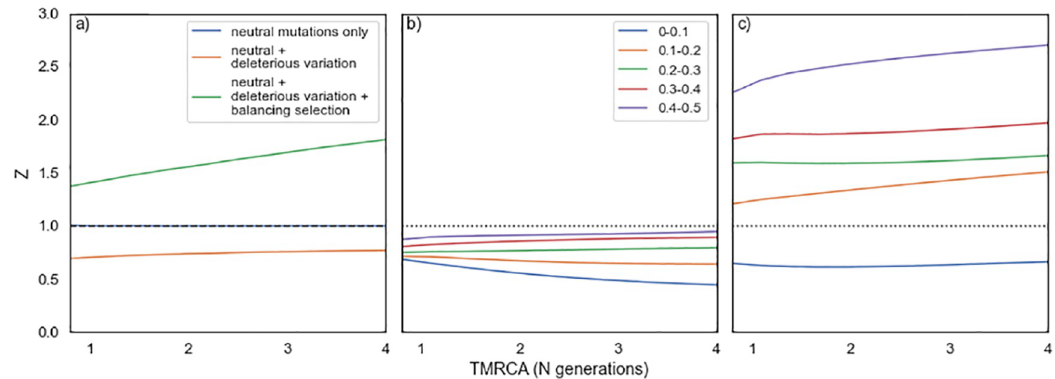
Fig 1. Stationary population size simulations. The ancestral population is duplicated to form 2 daughter populations of the same size to each other and the ancestor. The tMRCA is measured in N generations, where N is the population size. In panel (a), we show the value of Z as a function of the tMRCA for 3 scenarios: all nonsynonymous mutations are neutral; all nonsynonymous mutations are deleterious; and all nonsynonymous mutations are neutral except for a single balanced polymorphism in the middle of the locus. In panels (b) and (c) polymorphisms have been binned by minor allele frequency, in bins of size 0.1. In panel (b), we show the case where all nonsynonymous mutations are deleterious and panel (c) all nonsynonymous mutations are deleterious except for a single balanced polymorphism in the middle of the locus. Code to perform these simulations can be at https://github.com/vivaksoni/test_ for_balancing_selection. tMRCA, time to the most recent common